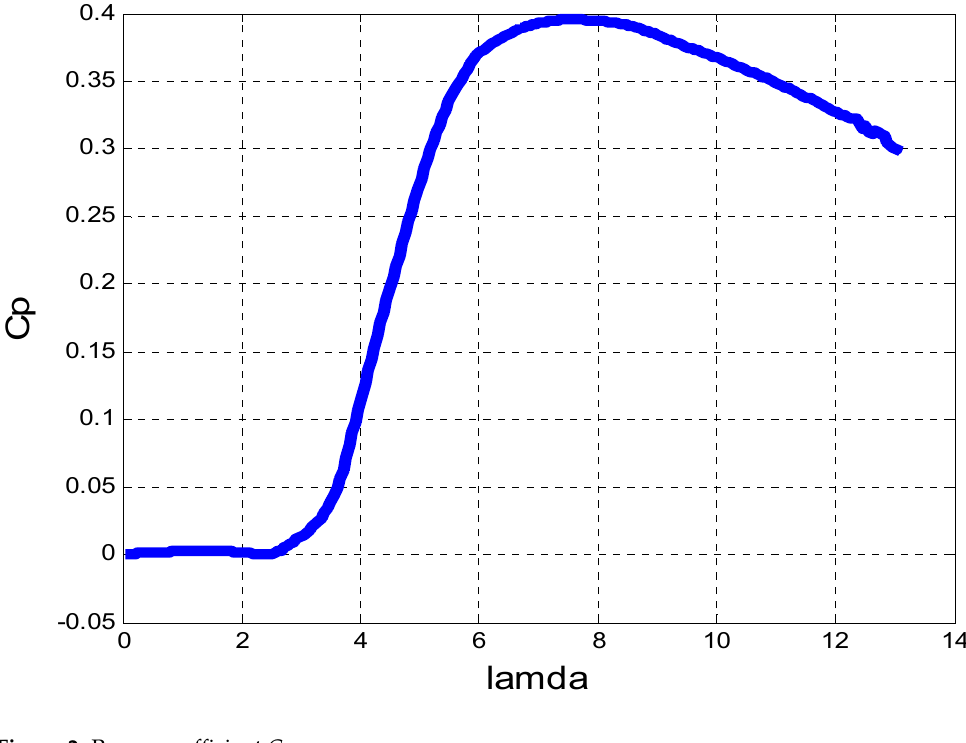
Figure 2. Power coefficient C p curve.